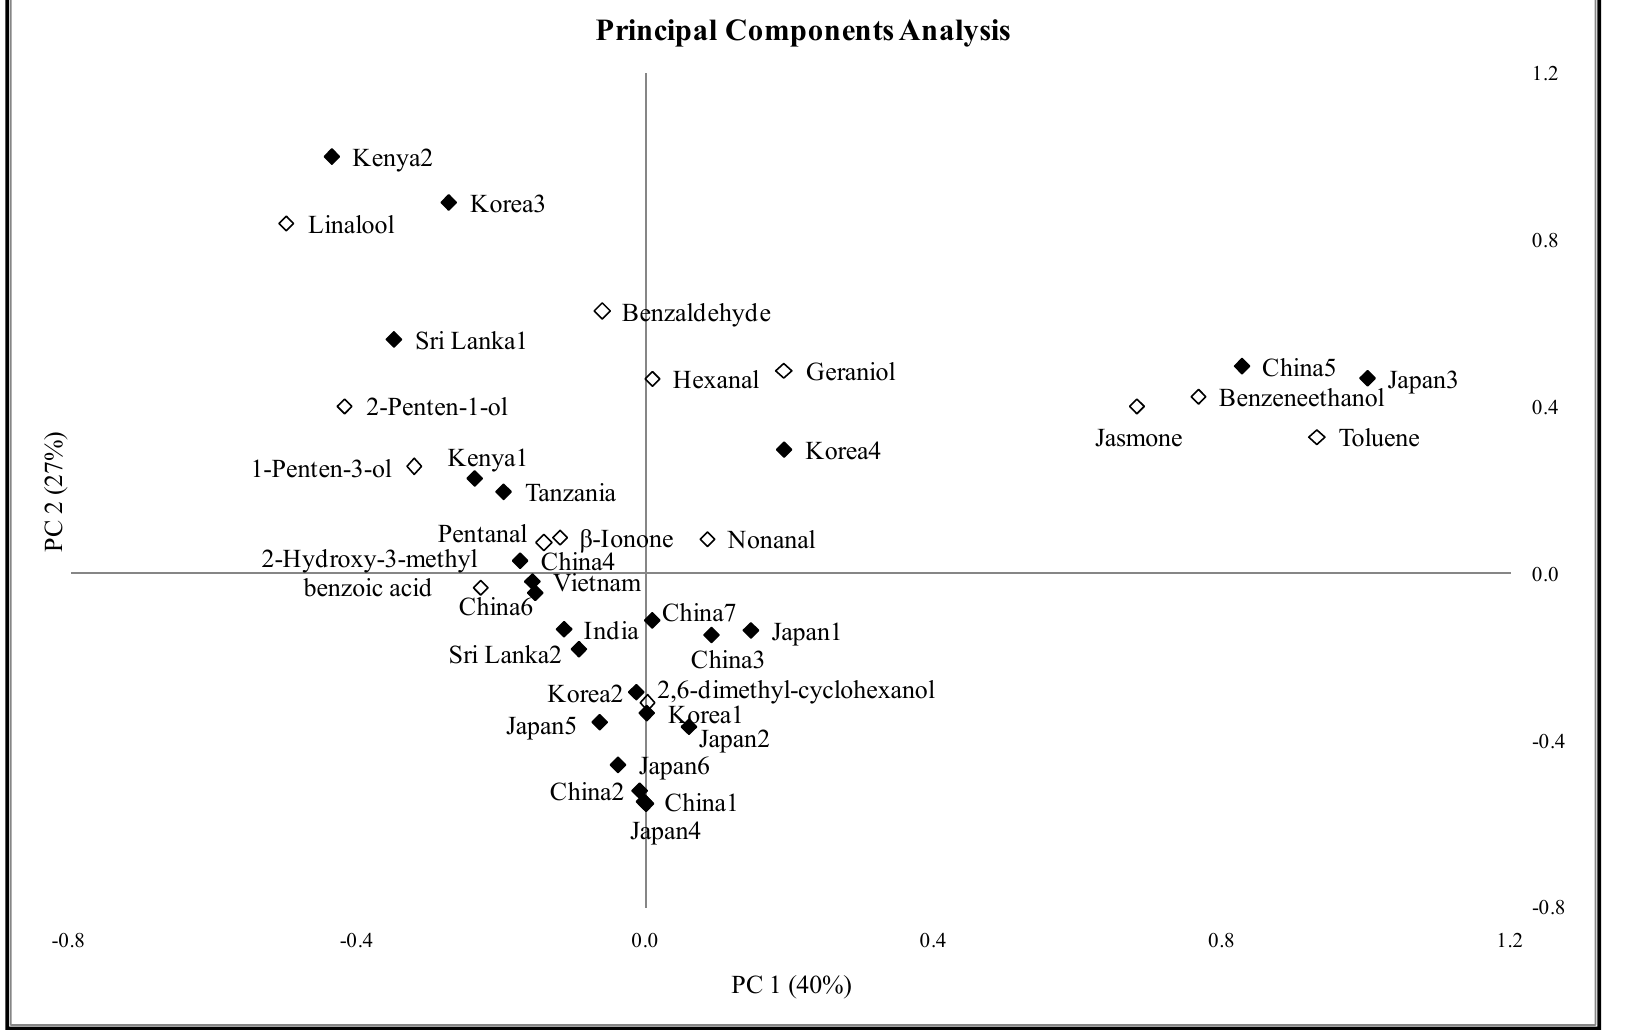
Figure 1. Principal components analysis biplot showing relationship between the green tea samples (  ) and the volatile compounds ( 